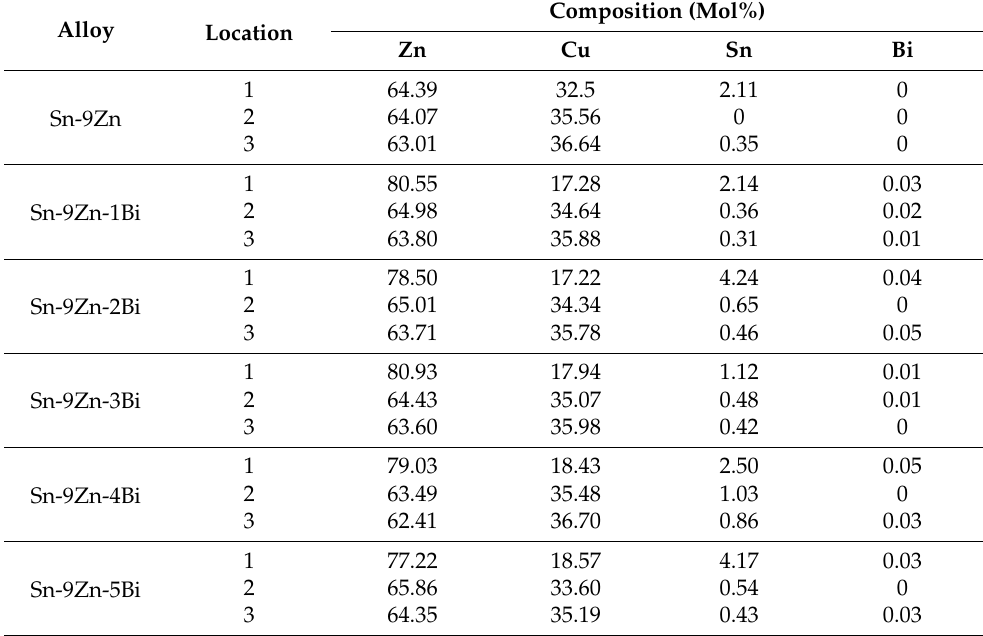
Figure 14. Schematic diagram of cross-sections of IMC layer formed in Sn-9Zn-xBi/Cu solder joint.